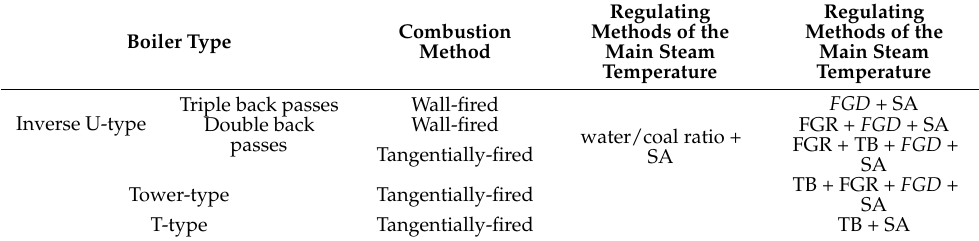
Table 1. The detailed methods of temperature regulation of different types of double-reheat boilers in